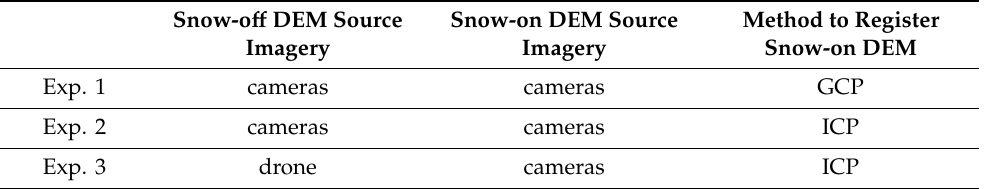
Table 1. Characteristics of the three experiments to compute the snow-on surface elevation (GCP: ground control point, ICP: iterative closest